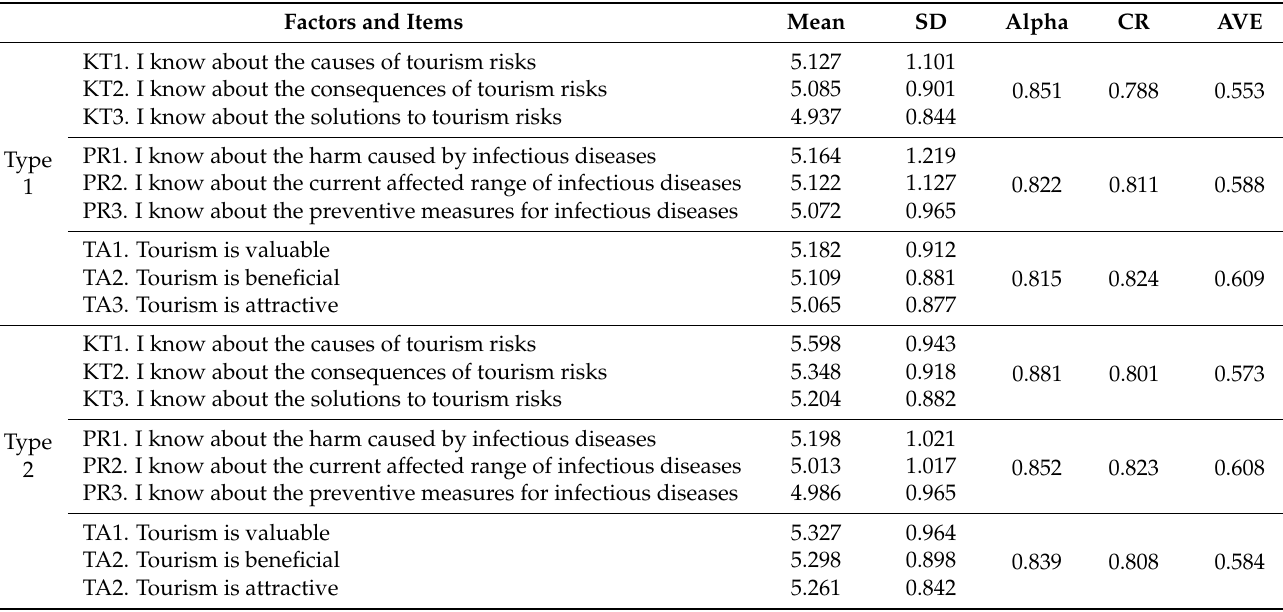
Table 3. Results of validity and reliability analyses.